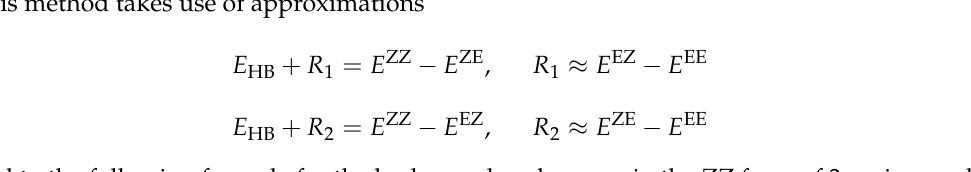
Figure 9. Four conformers of 3-aminoacrolein and energetic relationships between